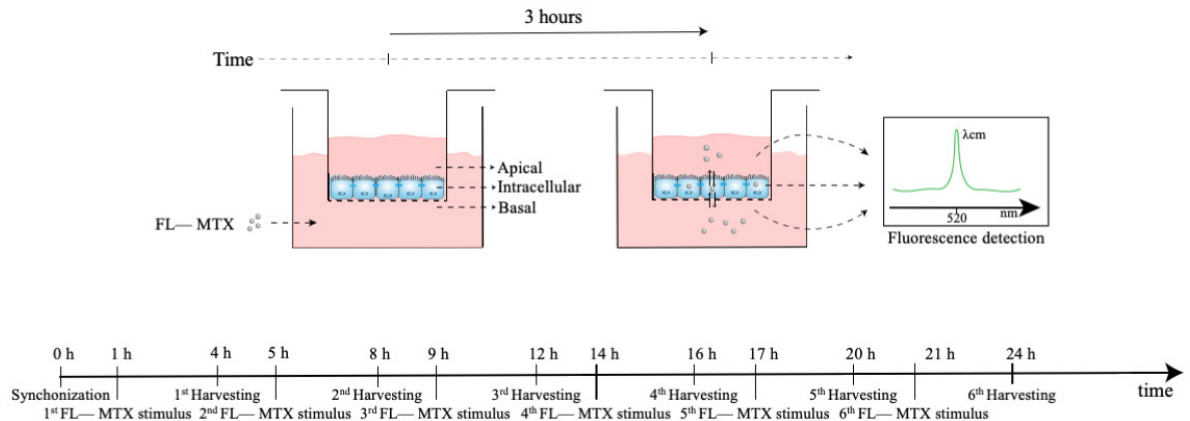
Figure 7. Scheme of the MTX uptake assay. At 0 h, the cells were synchronized using dexame- thasone. At six different time points (1, 5, 9, 14, 17, and 21 h after synchronization) the transwell inserts were incubated with MTX in the basal compartment for 3 h. After the incubation, the MTX levels in the basal, intracellular, and apical compartments were assessed by fluorescence analysis.